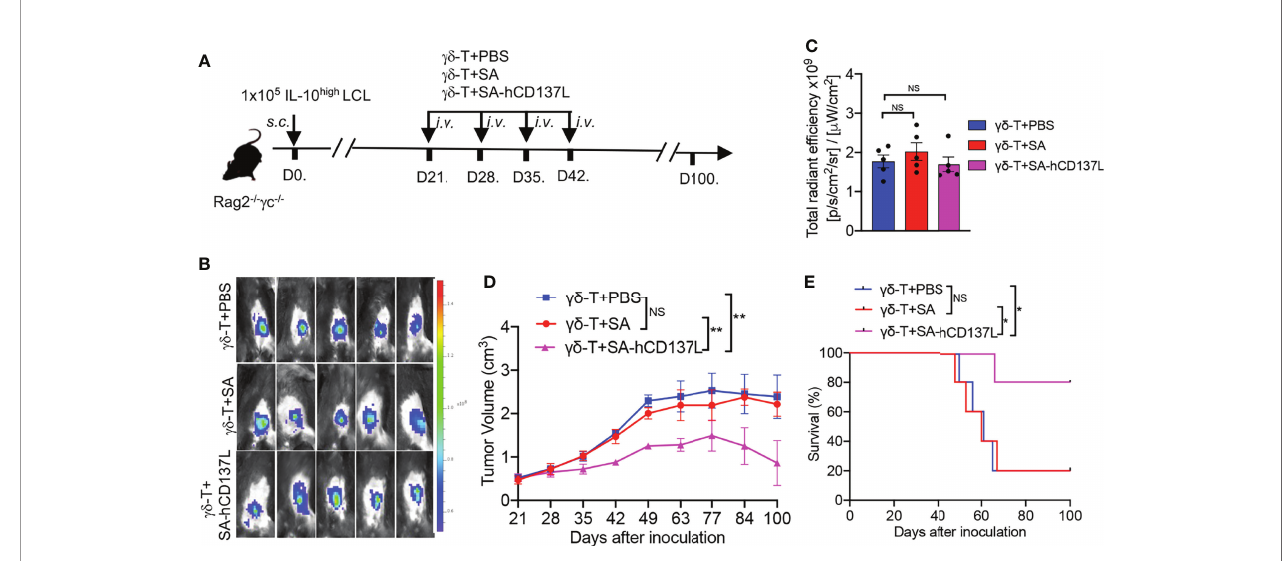
FIGURE 4 | CD137 costimulation enhanced the compromised antitumor activity of V g 9V d 2-T cells with IL-10 high TME in Rag2 -/- g c -/- mice. (A) Protocol for evaluation of the synergistic therapeutic effect of V g 9V d 2-T cells and SA-hCD137L on EBV-induced lymphoma in Rag2 -/- g c -/- mice ( fi ve mice per group). (B, C) Whole-body fl uorescence images (B) and total radiant ef fi ciency (C) of mice before treatment with PAM, SA-hCD137, SA, and PBS. (D, E) The tumor volume (D) and mouse survival (E) were determined at the indicated time. The tumor volume was analyzed by two-way ANOVA test, and mice survival was analyzed by Kaplan-Meier log-rank test. Data are representative for three independent experiments. *p < 0.05; **p < 0.01; ns, no signi fi cant